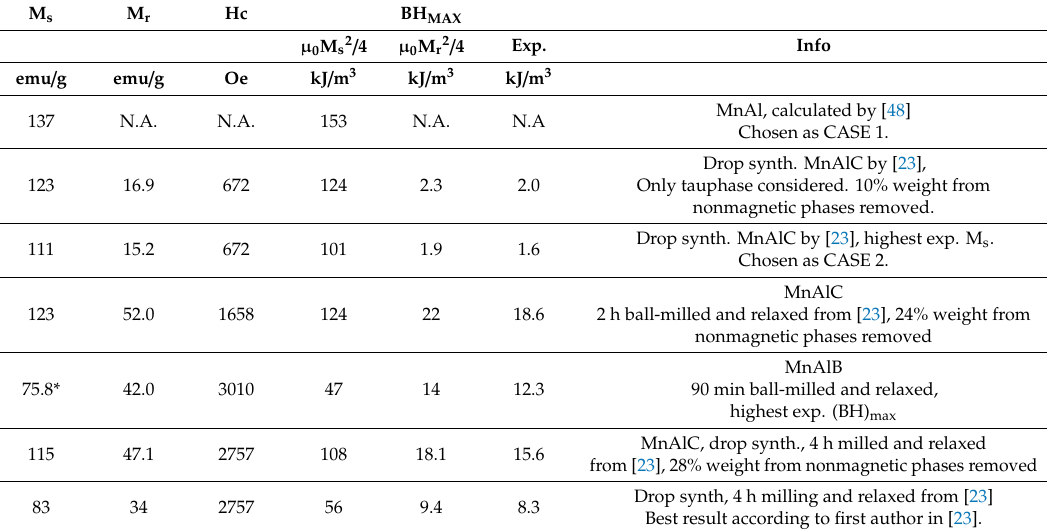
Table 2. Magnetic properties of calculated MnAl and experimental MnAl with an addition of carbon and